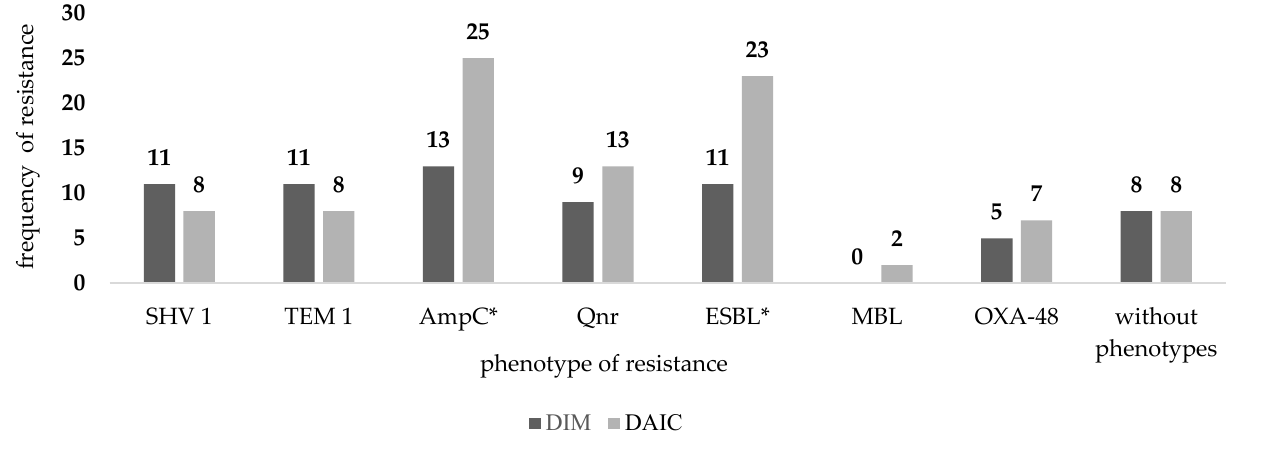
Figure 3. Number of individual phenotypes of resistance in isolated gram-negative nosocomial rods by department (statistically significant in cases AmpC and ESBL, statistically evaluated by chi-square test, p = 0.047 for AmpC, and p = 0.041 for ESBL, *—significant).